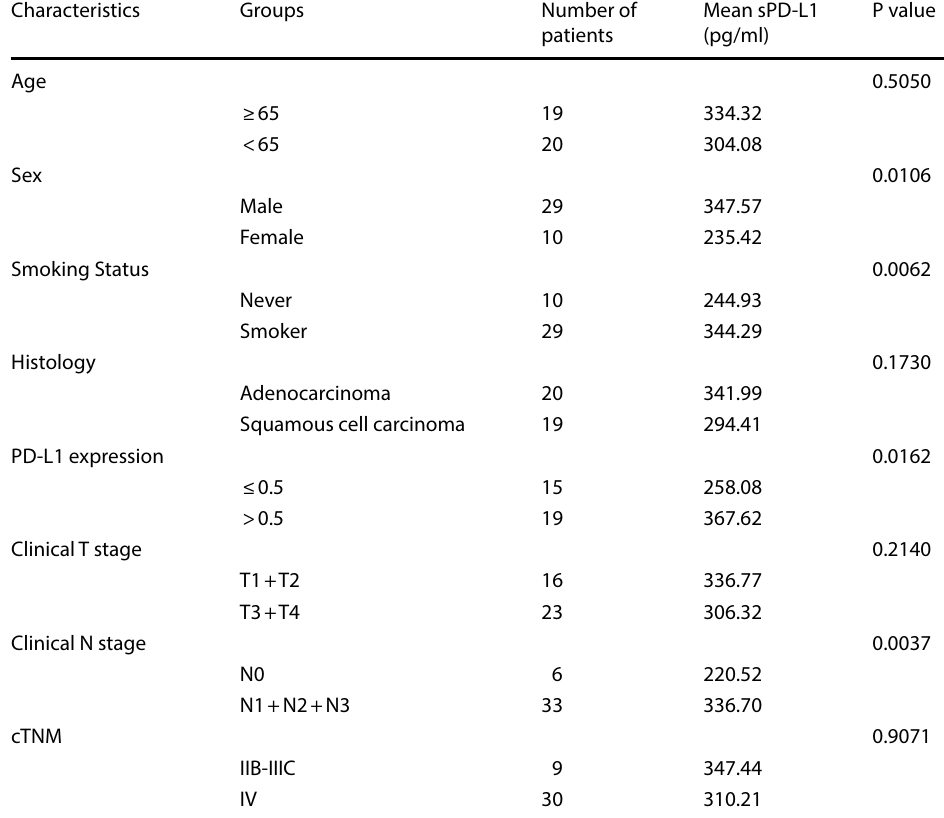
Table 1 Correlation between baseline functional sPD-L1 and clinical